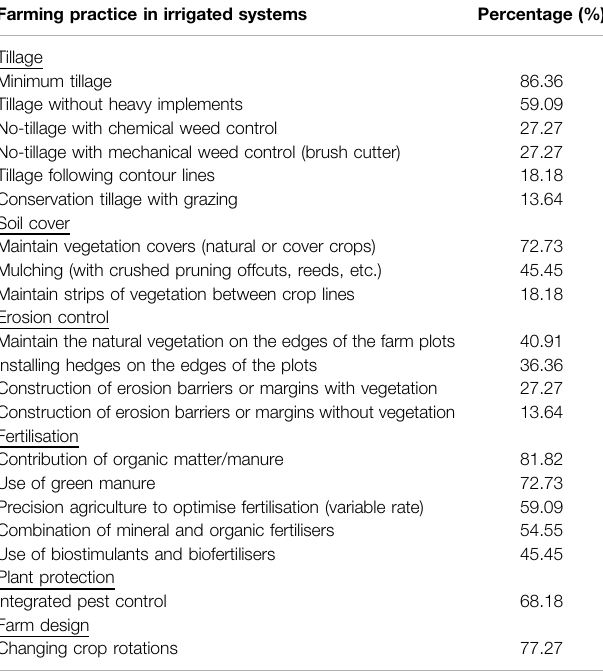
TABLE 6 | Identi fi cation of adequate farming practices for irrigated cereal-based cropping system, listed in a decreasing order. For each practice, values refer to the percentage of stakeholders that identi fi ed it